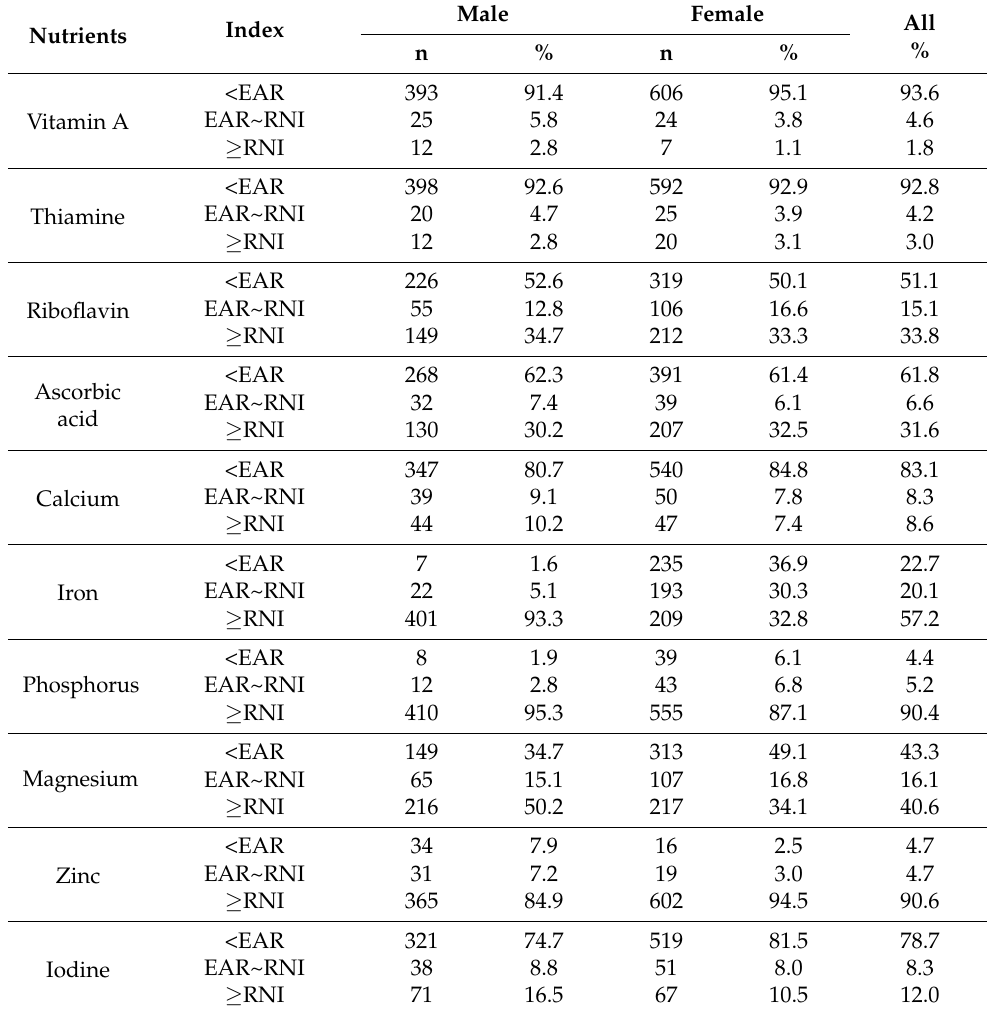
Table 6. Distribution of major nutrient intakes in the